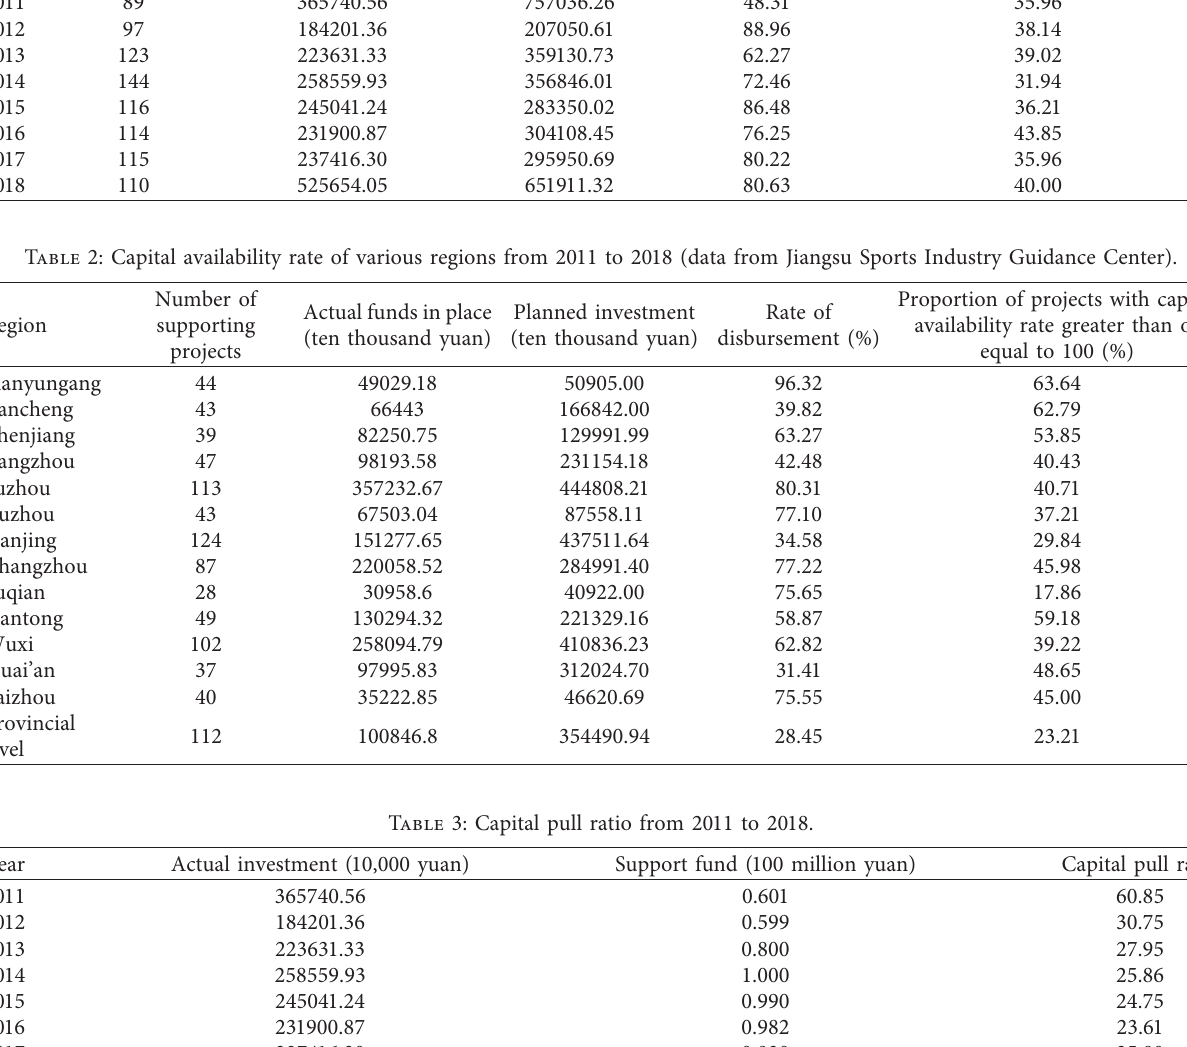
Table 1: Capital availability rate of each year from 2011 to 2018 (data from Jiangsu Sports Industry Guidance Center). Time